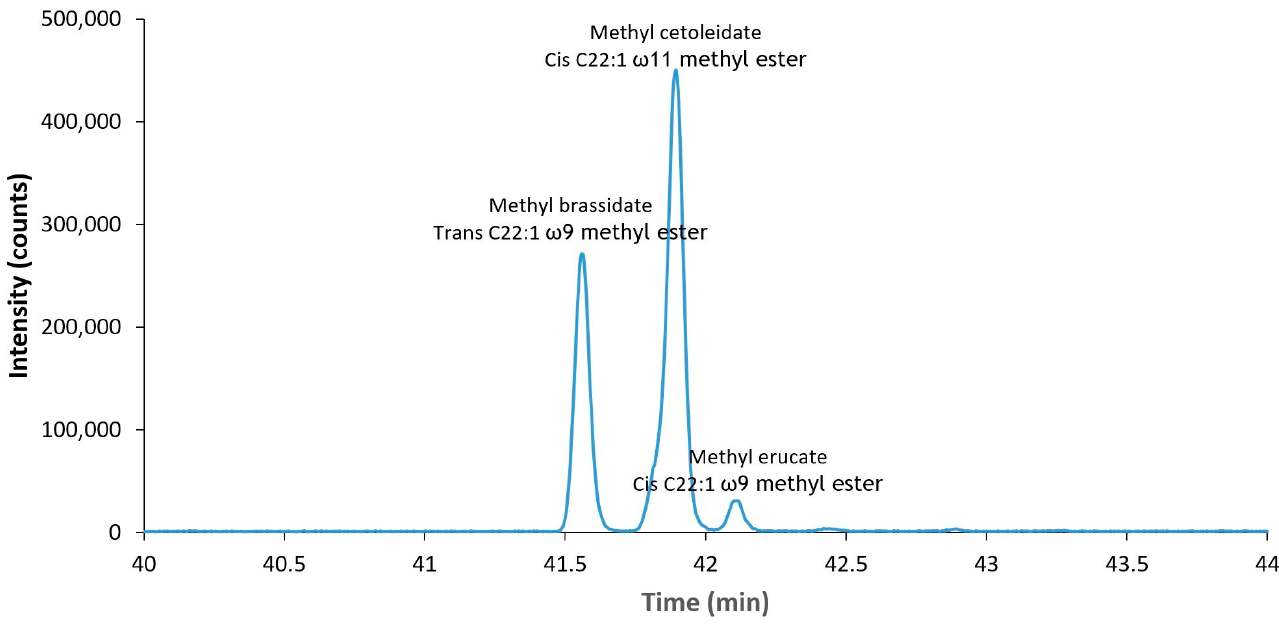
Figure 2. Separation of methyl brassidate, methyl cetoleidate and methyl erucate on a Restek Rt-2560, 100 m column. Table 2. Quantity of erucic acid ( µ g/g of sample) in rapeseed cake and protein products CPR1- 4 and HPR 1-3 for different extraction (E) and derivatization (D) methods (E1: Folch method, E2: Soxhlet method; D1: HCl/methanol derivatization, D2: NaOH/BF 3 derivatization, D3: H 2 SO